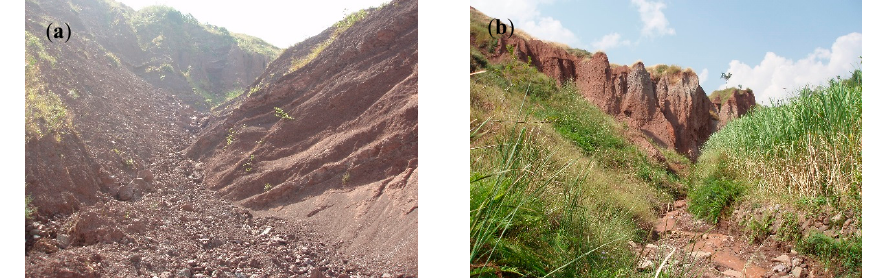
Figure 10. Geological and environmental conditions of the Shenyuhe debris flow gully. ( a ) loose materials deposited along the main channel; ( b ) unstable slopes composed of sediments of the Madianhe Group and a small mudflow.